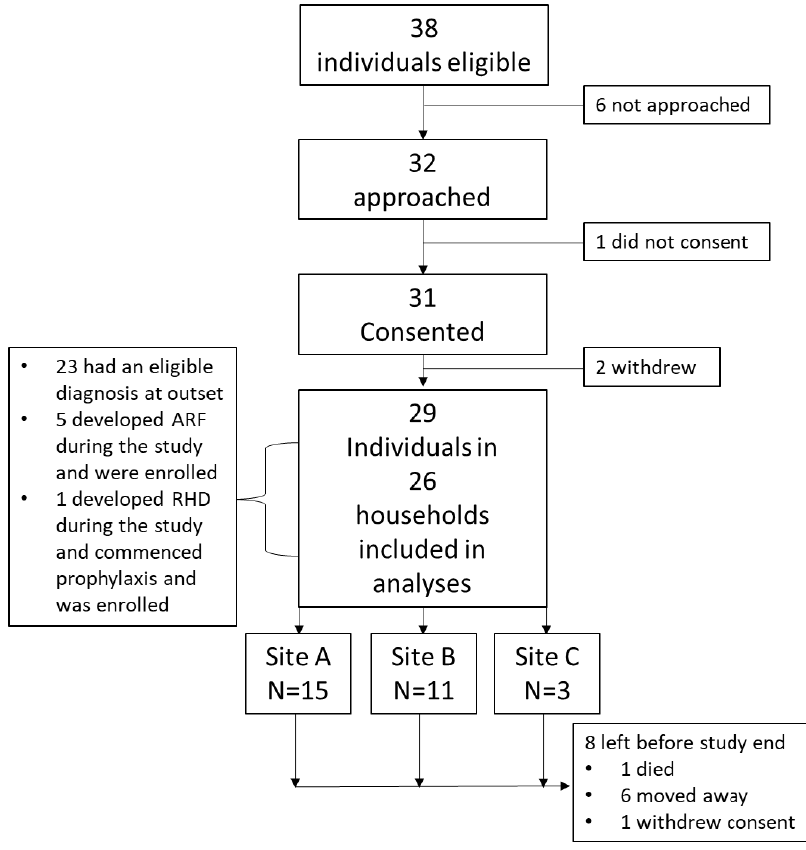
Figure 2. Study enrolment diagram. Table 1. Primary participant demographic, clinical and household characteristics.